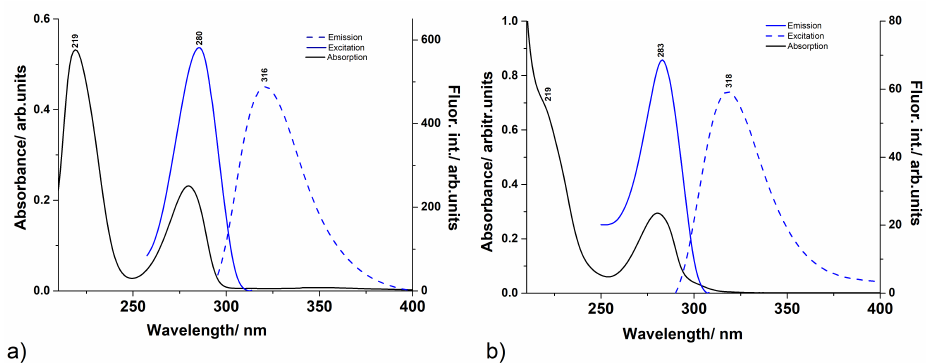
Figure 4. UV–Vis absorption spectra together with the fluorescence emission and excitation spectra recorded from dopamine solutions at pH 5.5 ( a ) and pH 8 ( b ),